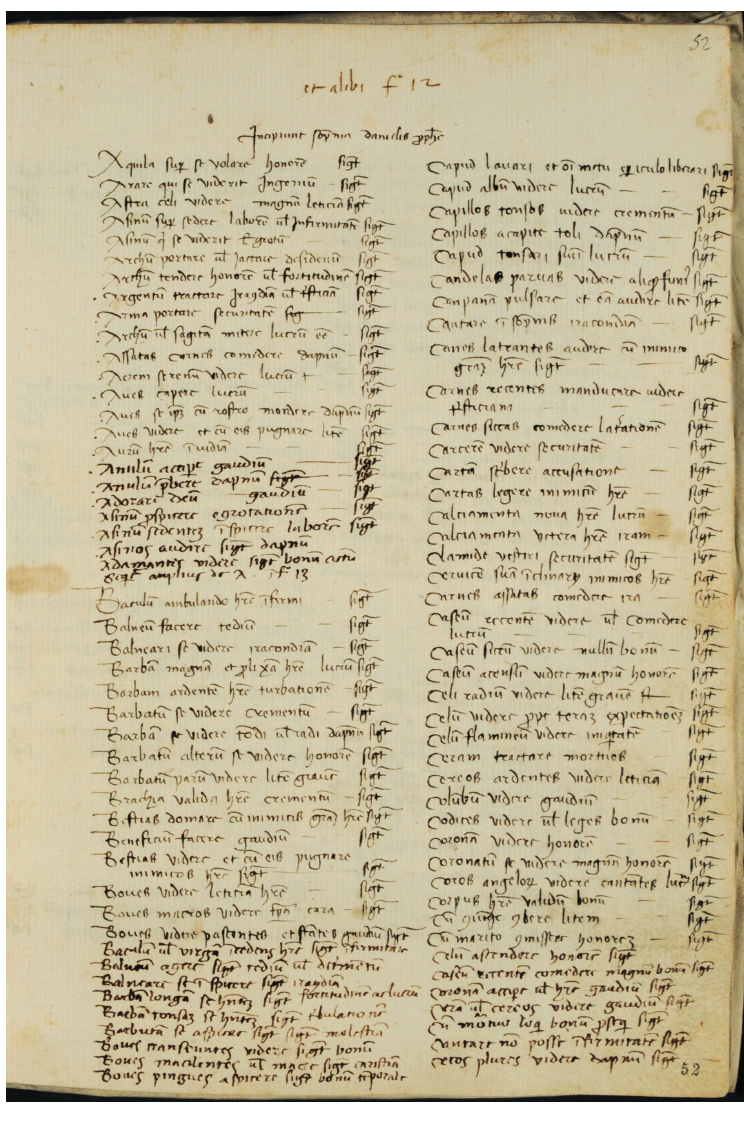
Fig. 3: Florence, Biblioteca Riccardiana, MS 859, fol. 52r , courtesy of the Ministry of Cultural Heritage and Activities and Tourism. Further repro- duction by any means is